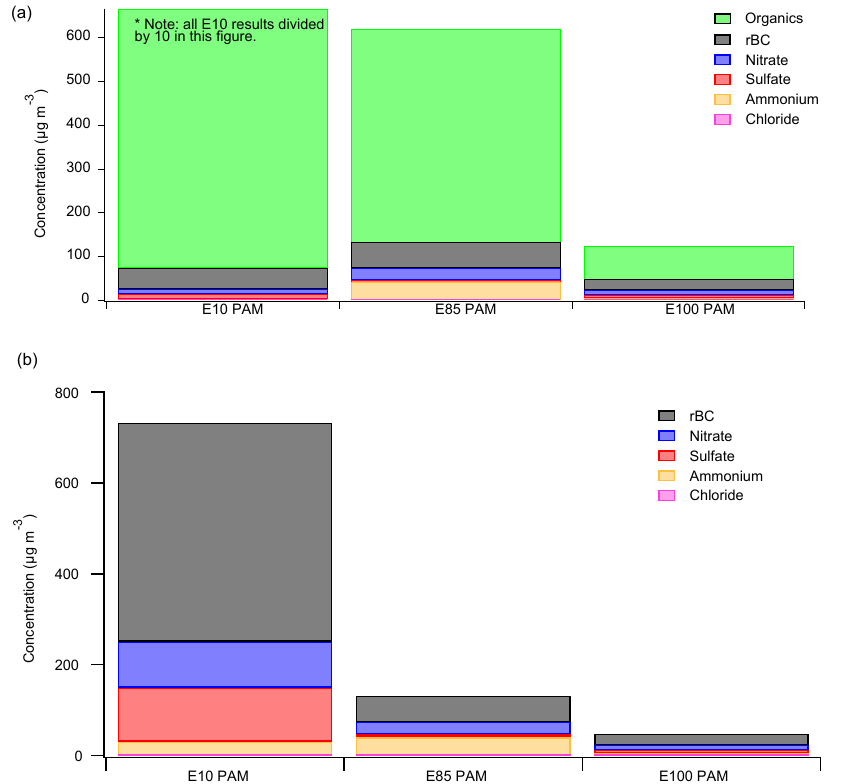
Figure 4. The composition of the particulate emissions after the PAM chamber for E10, E85 and E100 ( a ; in the left figure, all E10 results are divided by 10 in order to show all results in the same y axis). The concentration of the inorganic ions and rBC after the PAM chamber for E10, E85 and E100 (b)